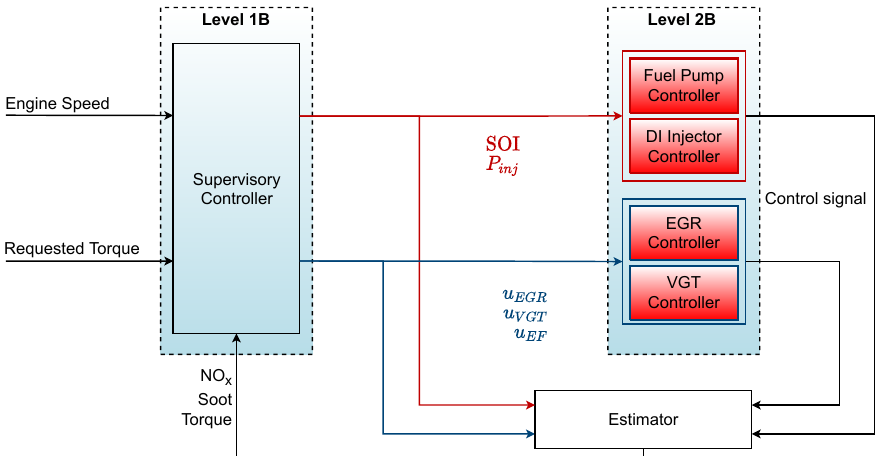
Figure 7. Architecture of a supervisory model predictive controller (L1B) and actuator controller as L2B to minimize engine-out emissions of NOx and soot of a diesel fueled CI engine—This includes a two-level hierarchy ICE control based on topology III where the VGT, EGR, EF (Exhaust flap), SOI, and fuel rail pressure ( P inj ) are generated by supervisory control and PIL model controller using actuator-generated control signal based on L1B control actions (based on [135]).